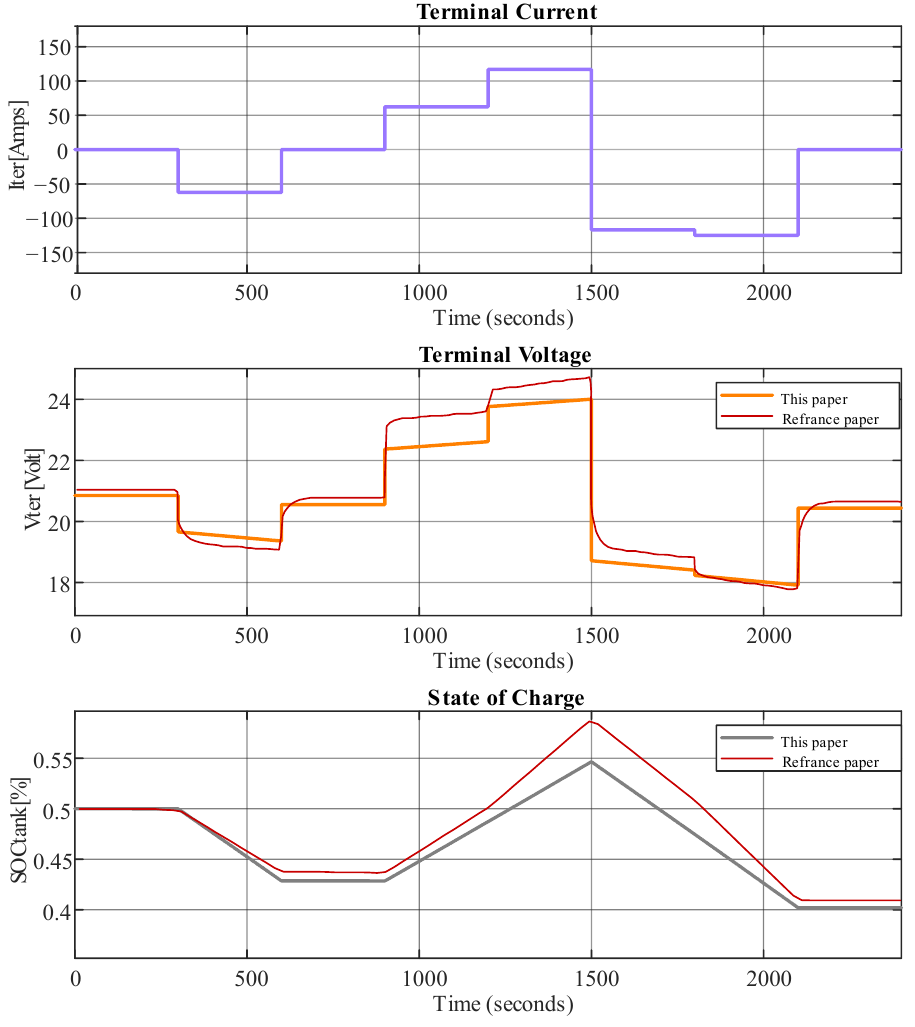
Figure 8. Model comparison with the reference model study in [18].